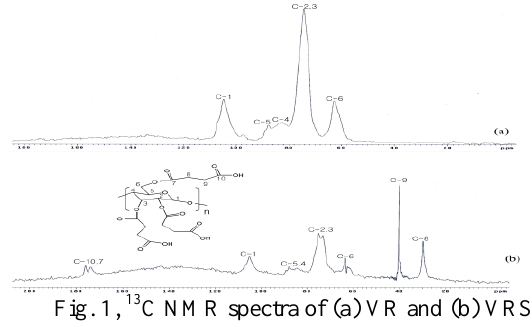
Fig. 1, 13 C NMR spectra of (a) VR and (b) VRS